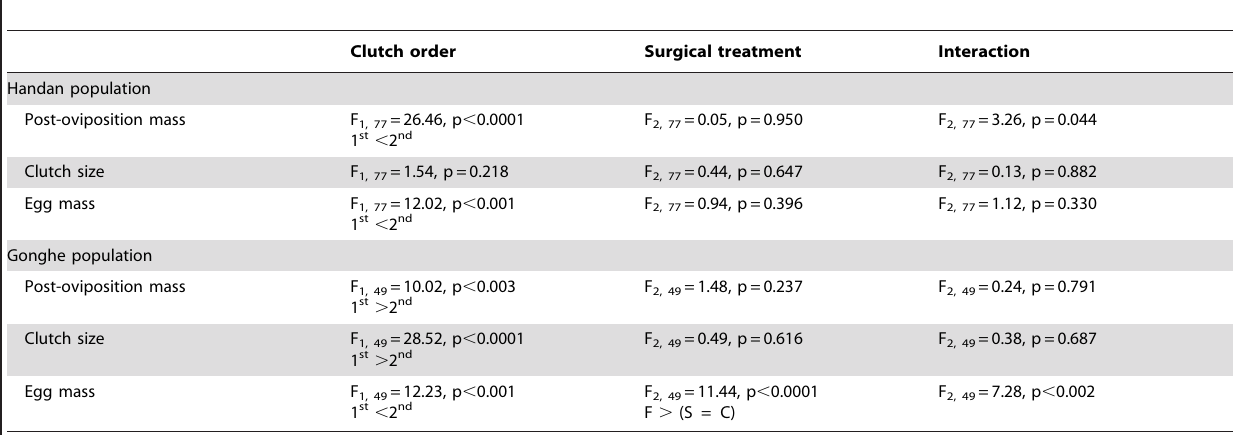
F: follicle-ablated females; S: sham-ablated females; and C: control females. Tukey’s post hoc comparison was performed on the trait that differed among females of the three